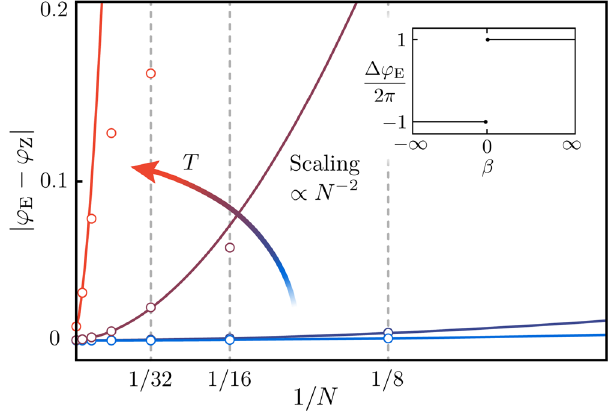
− φ FIG. 2. Scaling of finite-size corrections j φ in the finite- E Z j temperature Rice-Mele model, for different temperatures T ¼ 0 . 1 , ffiffiffi p 3 1, 10, and 100, with t 1 − t 2 ¼ − 1 /4 and Δ ¼ /4 in Eq. (33). Solid lines are fitting curves of approximately N − 2 , which provide N . Inset: Difference ½ 1 / ð 2 π Þ(cid:2) Δ φ accumulated per closed cycle in E ð t 1 − t 2 ; Δ Þ space encircling the purity-gap-closing point t 2 ¼ t 1 , Δ ¼ 0 , as a function of inverse temperature β . The same plot is found for N ¼ 8 , 16, 32, showing that the quantization of ½ 1 / ð 2 π Þ(cid:2) Δ φ E is independent of system size. As discussed in the main text, a topological transition occurs at infinite temper- ature ( β ¼ 0 ), where the purity gap globally closes, highlighting the key role of the